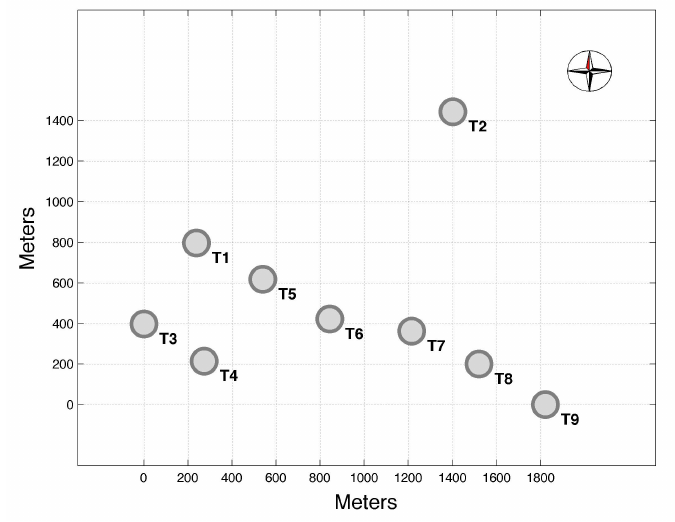
Figure 2. The layout of the test case 2 wind farm.